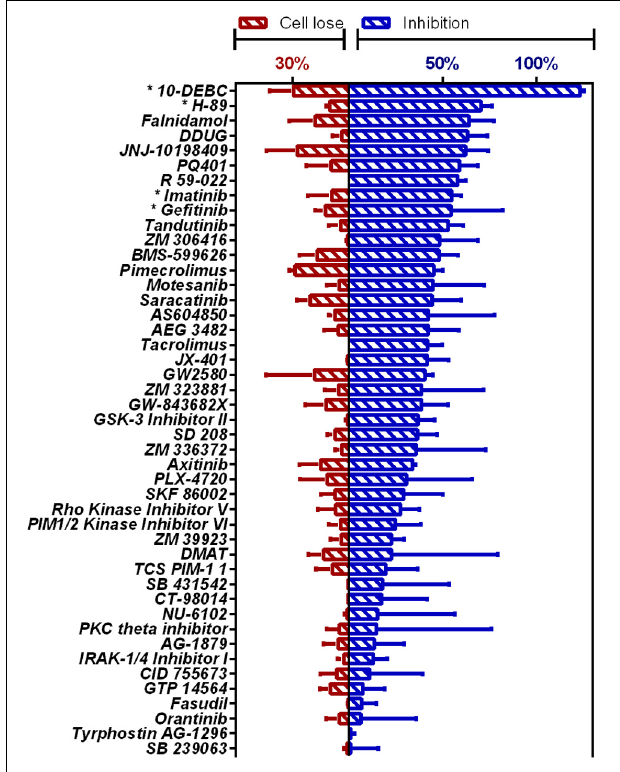
FIGURE 1 | HCS of OICR Kinase Inhibitor library against intracellular M.tb . Inhibition of M.tb growth (blue), interpolated to the negative control (1% DMSO) set at 0% inhibition and the positive control (4 µ M bedaquiline) defined as 100% inhibition. Cell loss (red), normalized to negative control. Previously identified host-targeting M.tb inhibitors marked with asterisk (*). Means from compounds with negative z -score and cell loss < 30% ( n = 45) are graphed. Error bars represent the SD from two independent screens. Full list of compounds and z -scores are tabled in Supplementary Table 2